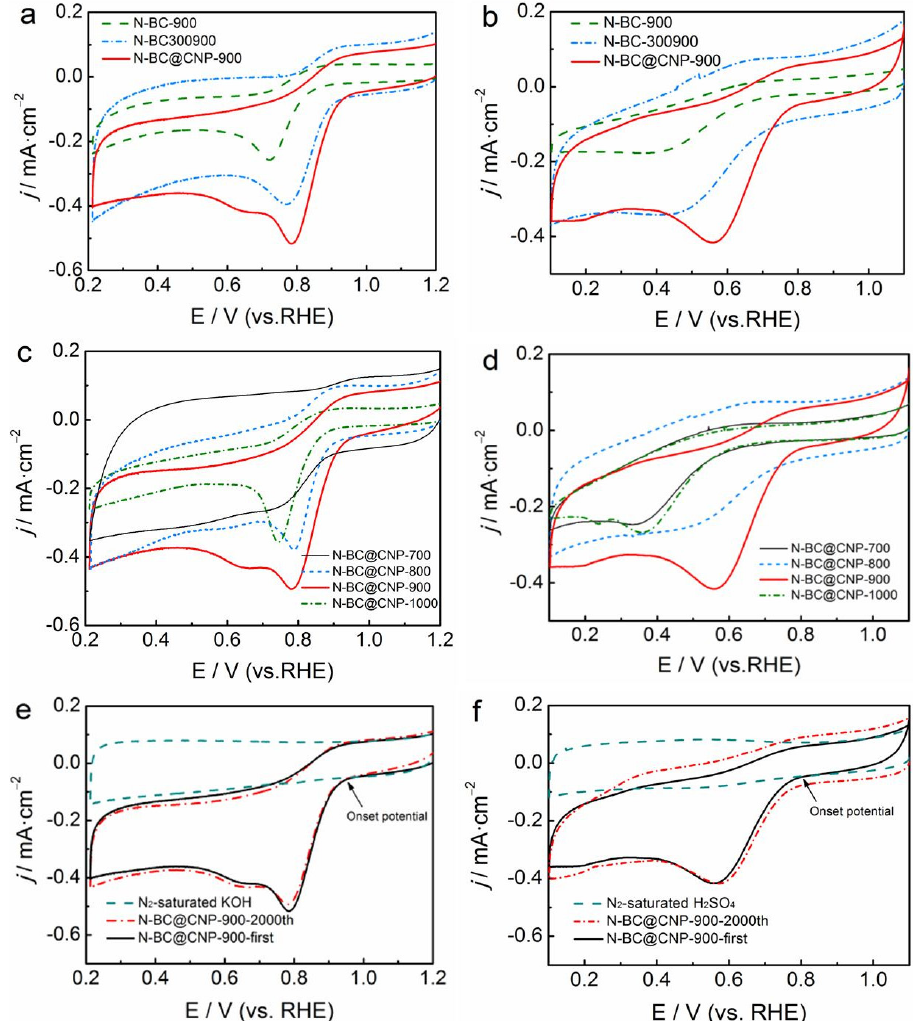
Figure 3. Cyclic voltammograms (CVs) of N ‐ BC ‐ 900, N ‐ BC ‐ 300900 and N ‐ BC@CNP ‐ 900 in O 2 ‐